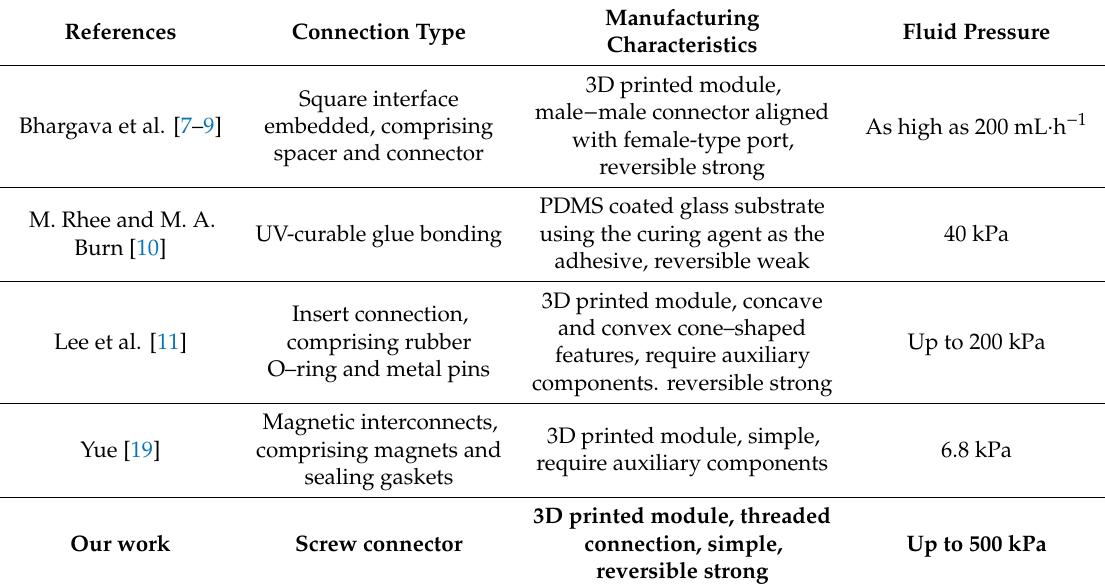
Table 1. Comparison of modular microfluidic systems.